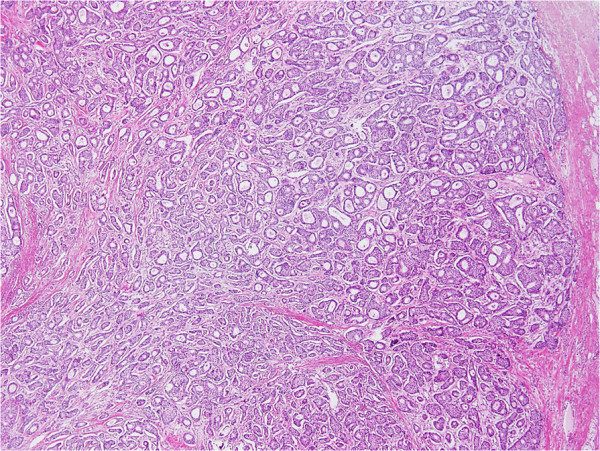
Representative histopathological specimens of the three subtypes of invasive ductal carcinoma–not otherwise specified. Papillotubular growing type (Papi-tub) is characterized by the projection of papillae into spaces, and includes cribriform and comedo patterns
[4].